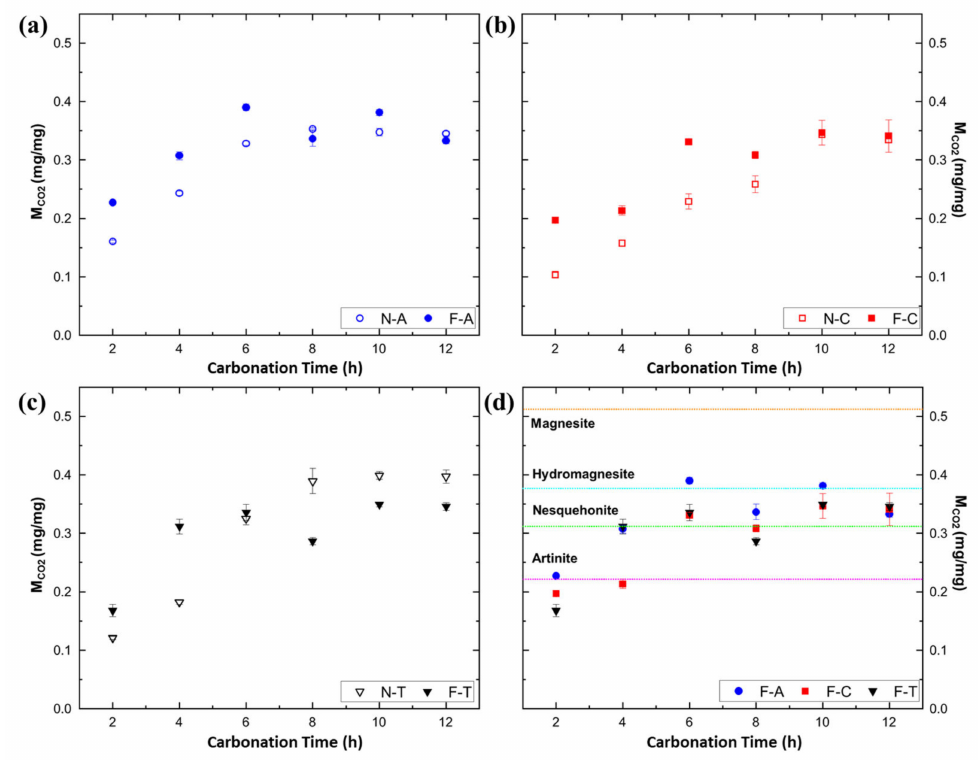
Figure 4. Adsorbed CO 2 masses per unit mass (M CO2 ) of the forced (F) or non-forced (N) wet carbonation products analyzed by GC-TCD for ( a ) A-MgO, ( b ) C-MgO and ( c ) T-MgO. ( d ) M CO2 of the F-carbonation products of the 3 MgO nano-adsorbents were compared with theoretical maximum CO 2 adsorption masses of the possible MgO carbonates such as magnesite, hydromagnesite, nesquehonite and